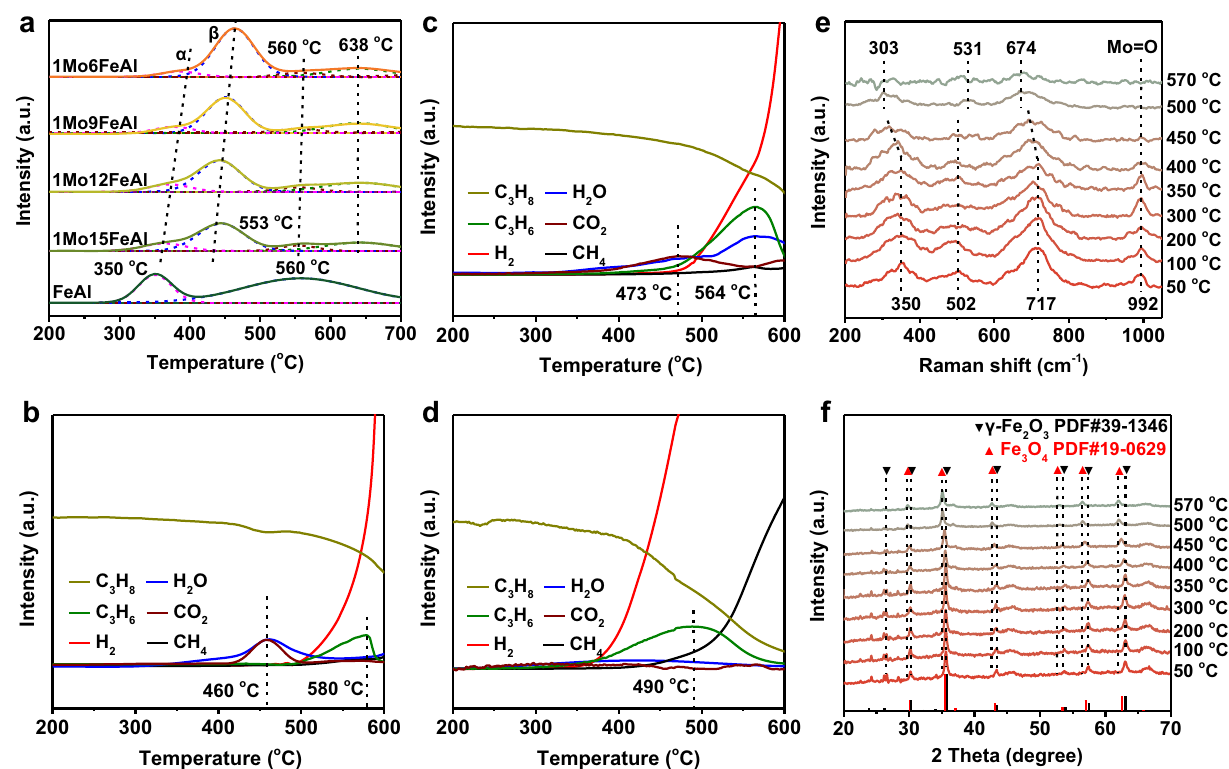
Fig. 5 | Modulation of overactive lattice oxygen species for MoO 3 -Fe 2 O 3 redox catalysts. ( a ) H 2 -TPR pro fi les of different redox catalysts ramping from 200 to 700°C with a rate of 10°C/min in a mixture of 10vol% H 2 in Ar(30mL/min). C 3 H 8 - TPR mass spectra of ( b ) FeAl, ( c ) 1Mo9FeAl, ( d ) MoAl. The C 3 H 8 -TPR experiments